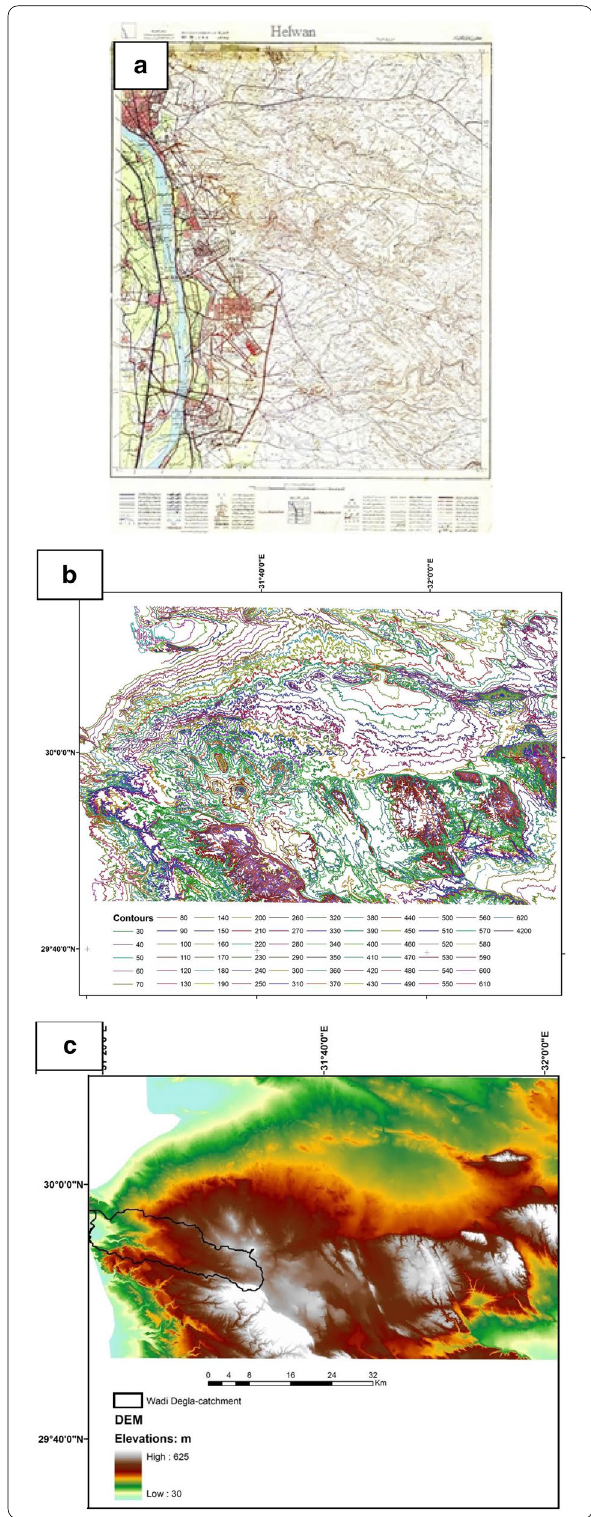
Fig. 5 a A sample of the scanned 1:50,000 topographic maps used to create a 20 m resolution DEM and to map the alluvial channels now concealed by the urban areas, b the digitized contours of the study area, and c the created DEM from the topographic contour maps, note the extent of Wadi Degla catchment